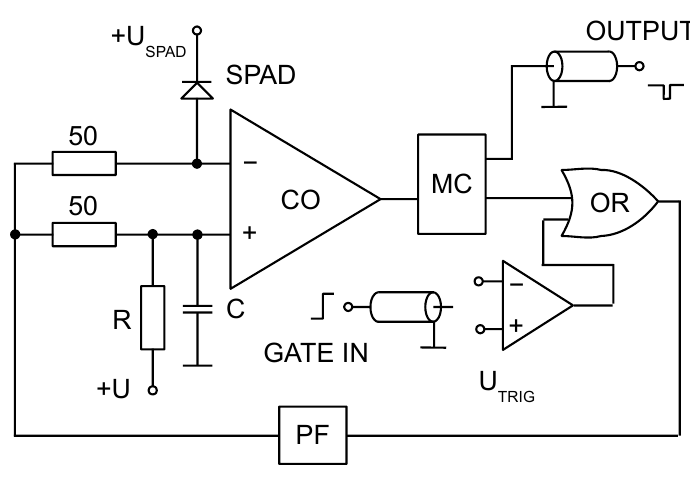
Figure 4. Block diagram of active quenching and gating circuit [10]. The reset (quenching) time of detector is determined mainly by a propagation delay of the comparator CO and the gate